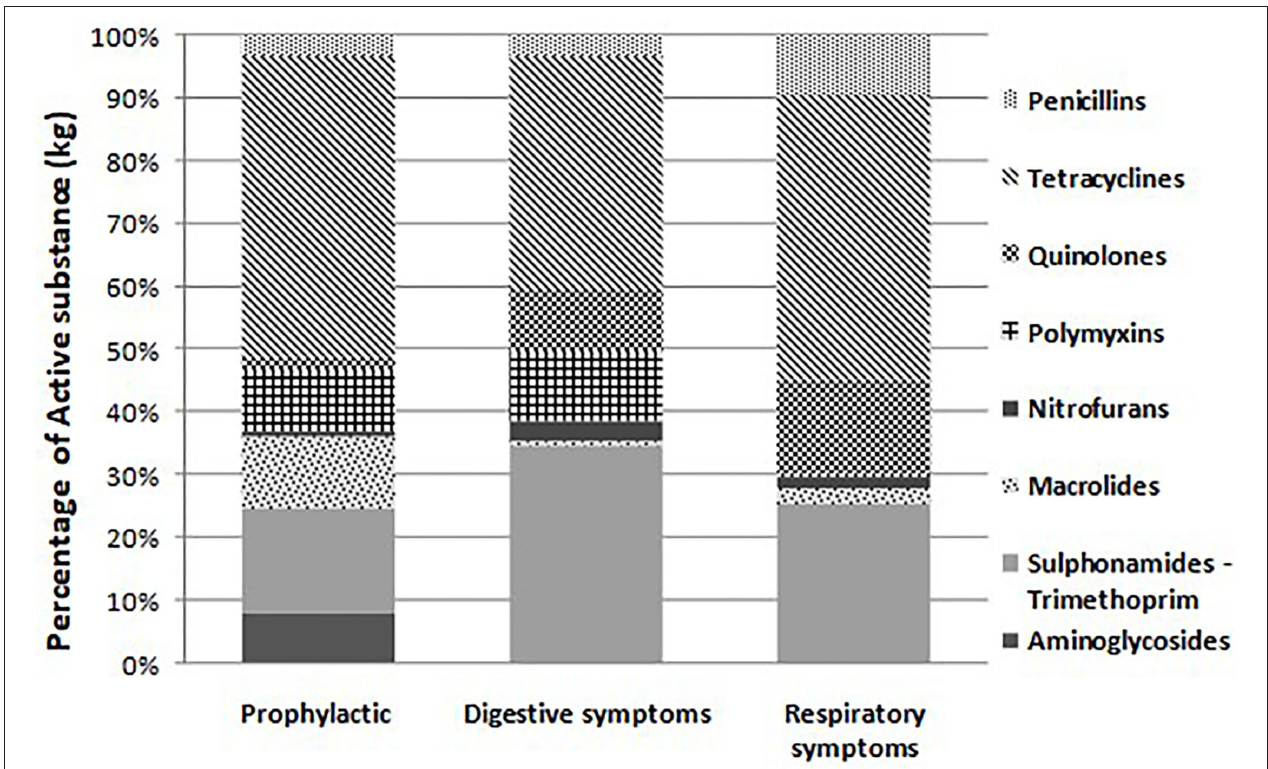
FIGURE 3 | Distribution of different antimicrobial classes used in 50 layer poultry farms in the West Region of Cameroon according to the different indications of use. Of the 297kg of antimicrobials used, 11.8% are for prophylactic use and 88.2% for metaphylactic use (24.3% for digestive symptoms and 63.9% for respiratory symptoms).